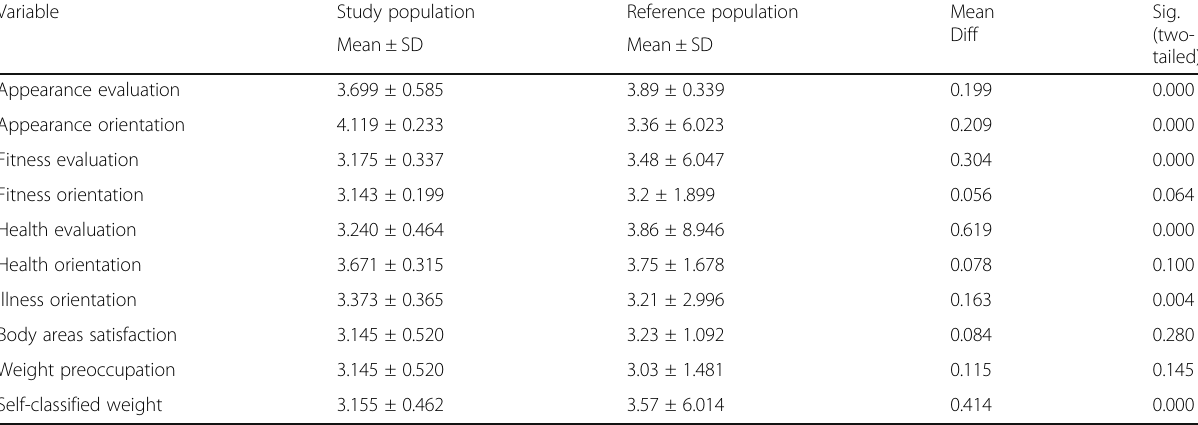
Table 2 Self-image assessment of subjects seeking rhinoplasty compared to the reference population